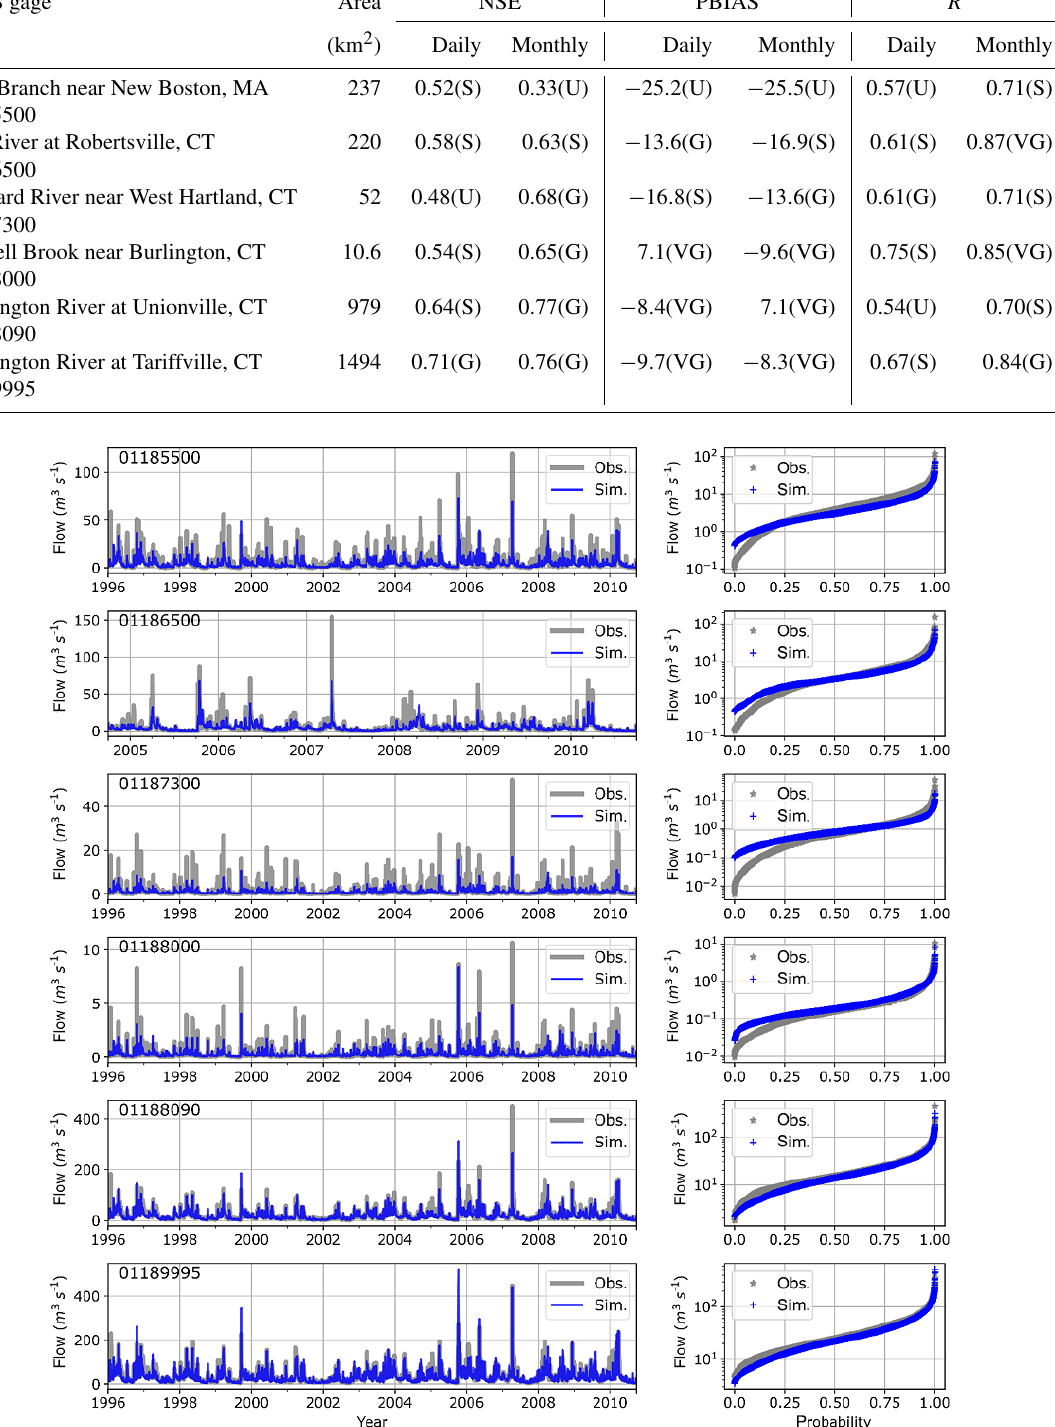
Figure 3. Time series and cumulative distribution function comparing simulated and observed daily stream flows at selected USGS gages in the Farmington River